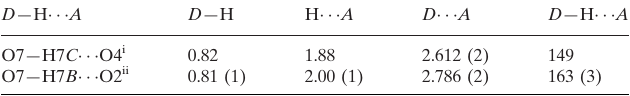
Hydrogen-bond geometry (A˚ , (cid:3)